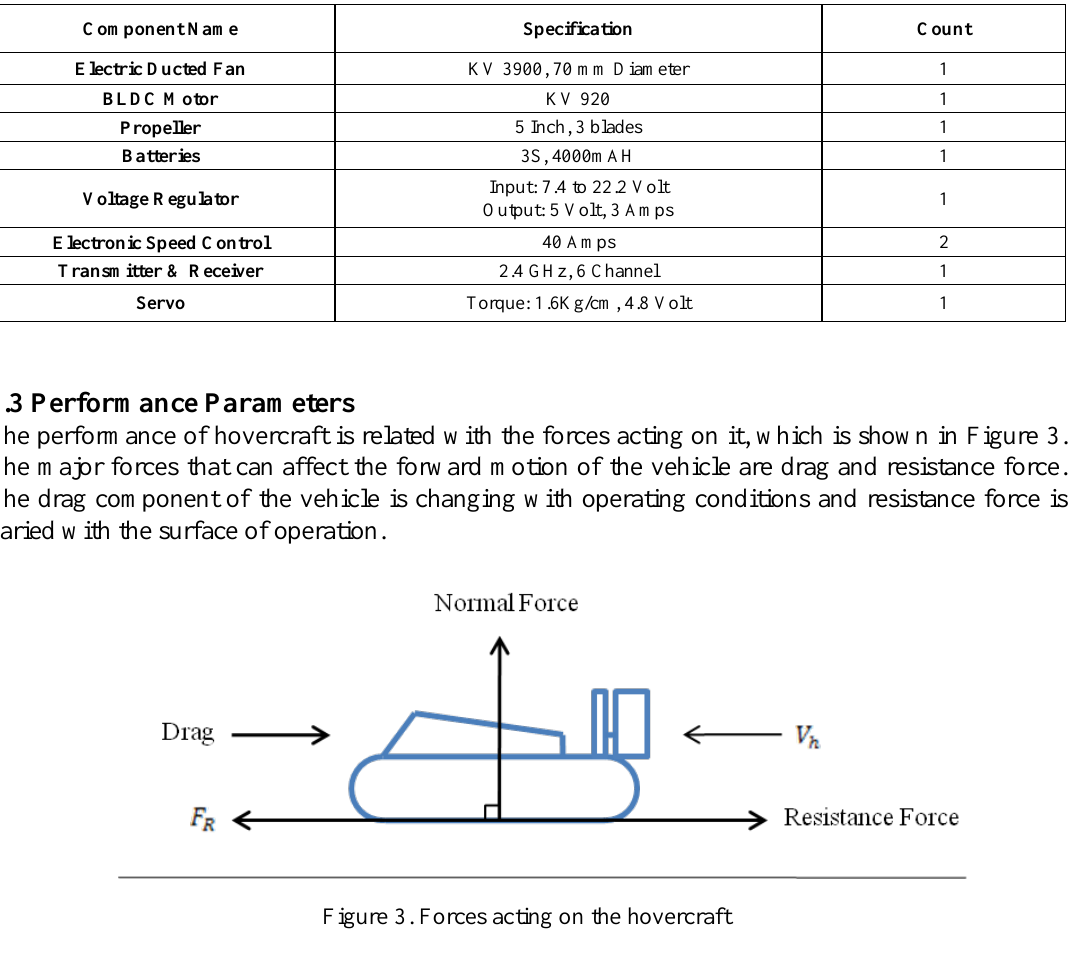
Table 2. List of on-board components